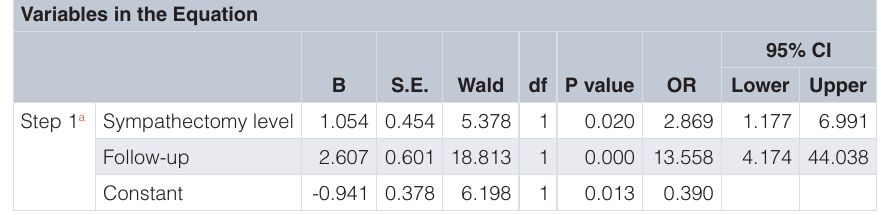
Classification Table: Percentage correctly predicting